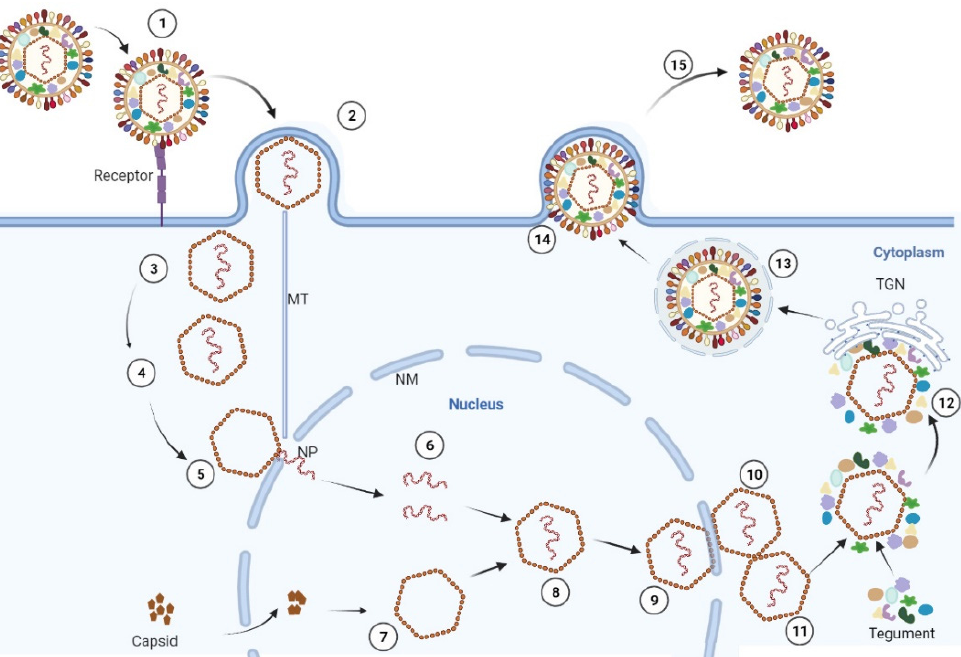
Figure 3. The replication cycle of PRV. After adsorption (1) and penetration (2), capsids are transported to the nucleus (3) via interaction with microtubules (MT) (4), docking at the nuclear pore (NP) (5) where the viral genome is released into the nucleus. In the nucleus, DNA replications occur (6). The capsid proteins are transported to the nucleus and are assembled around a scaffold (7), and then are assembled into a nucleocapsid with the insertion of the genomic DNA (8) . The nucleocapsid leaves the nucleus by budding at the inner nuclear membrane (INM) (9) , followed by fusion of the envelope of these primary virions located in the perinuclear space (10) with the outer nuclear membrane (11) . Final maturation then occurs in the cytoplasm by the secondary envelopment of intra-cytosolic capsids via budding into vesicles of the trans-Golgi network (TGN) (12) containing viral glycoproteins, resulting in an enveloped virion within a cellular vesicle (13) . After transport to the cell surface (14) , vesicle and plasma membranes fuse, releasing a mature, enveloped virion from the cell (15) .